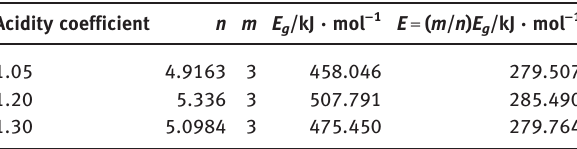
Table 2: Crystallization kinetics parameters of blast furnace slag fibers. Acidity